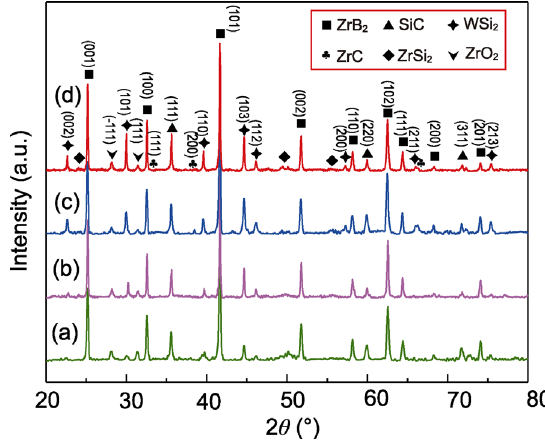
Fig. 2 XRD spectra of the final composites with different compositions: (a) RZSZ-10, (b) RZSZ-15, (c) RZSZ-20, and (d)